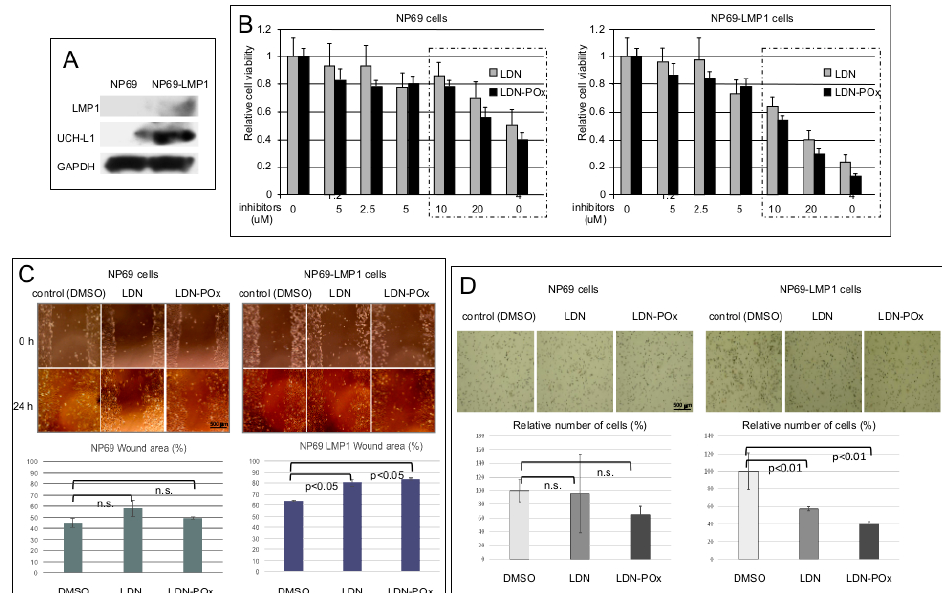
Figure 3. Both forms of UCH-L1 inhibitor, LDN and LDN-POx reduce motility of LMP1-positive nasopharyngeal cells. ( A ) De novo expression of UCH-L1 in LMP1-positive NP cells . Total lysates from LMP1-negative and LMP1-positive cells NP69 cells were separated in 12% polyacrylamide